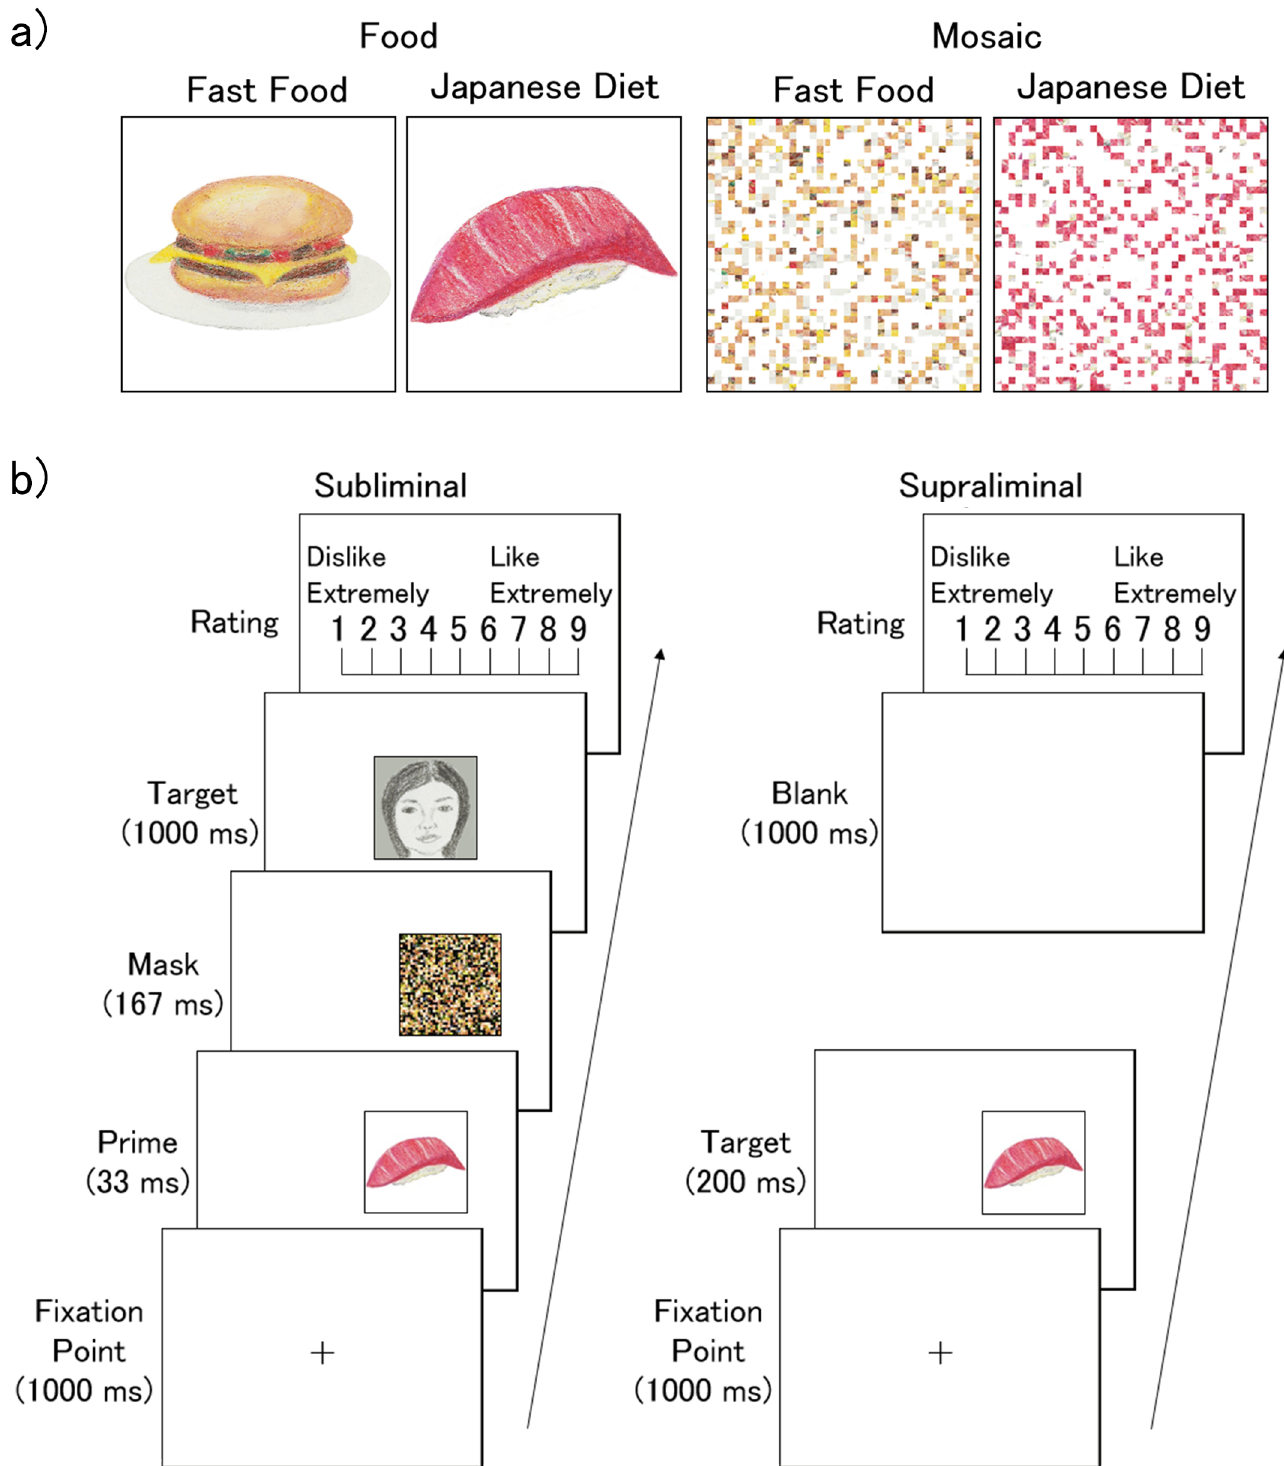
Fig 1. Illustrations of food and mosaic stimuli (a) and the trial sequences of the subliminal and supraliminal presentation conditions (b). In the actual experiment, photographic stimuli were used.